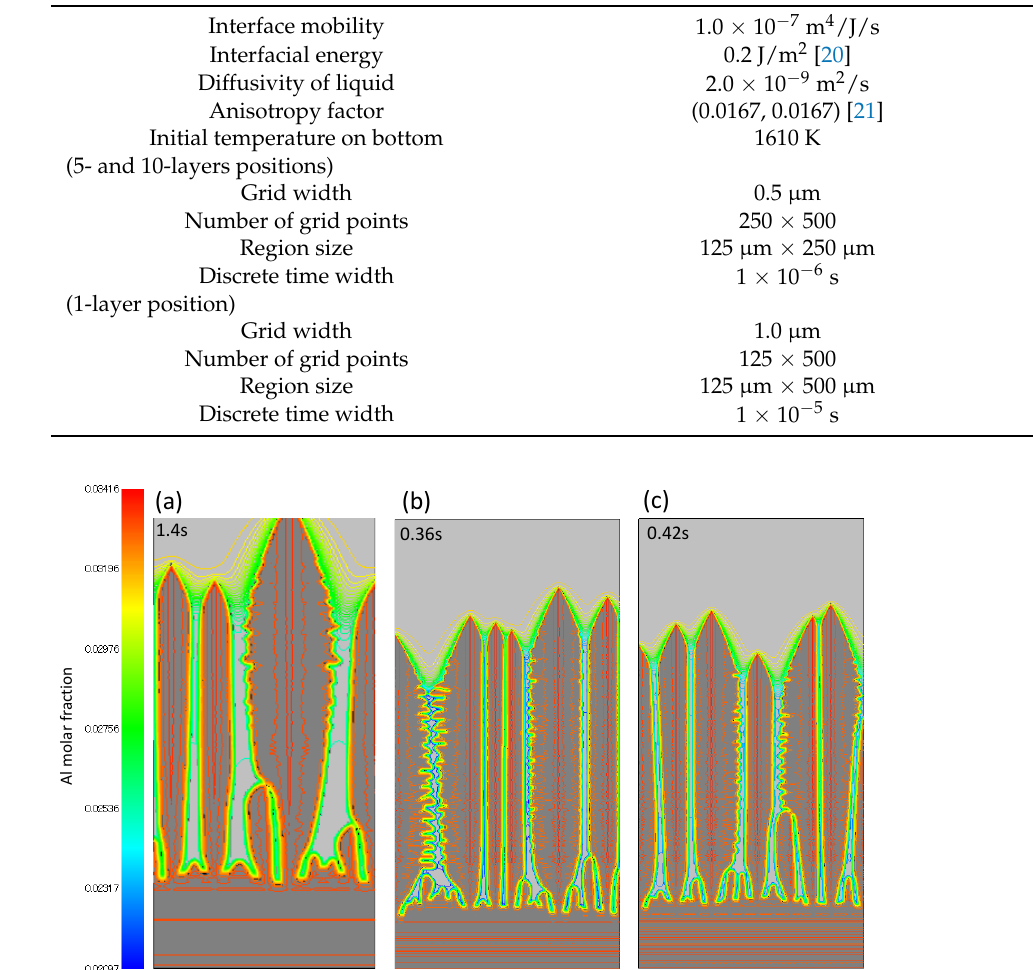
Figure 9. Al molar fraction distributions with phase distributions in the ( a ) first, ( b ) fifth, and ( c ) tenth layers at 1.4 s, 0.36 s, and 0.42 s, respectively.